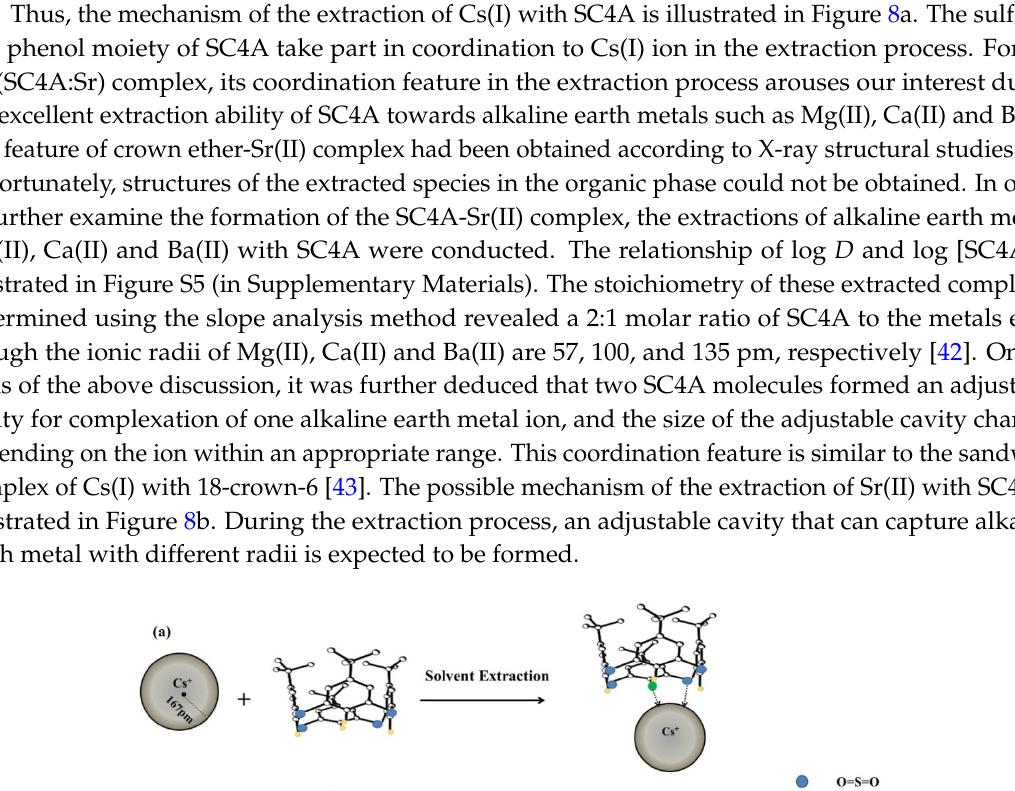
Figure 7. IR spectra (KBr) of SC4A and extracted species: ( a ) SC4A; ( b ) SC4A ‐ Cs(I) complex; and ( c ) SC4A ‐ Sr(II) complex. Conditions: T = 298 K, [SC4A] (o) = 1 × 10 − 3 M, [Metal] (a) = 1 × 10 − 4 M, contact time = 60 min, pH = 6, shaking speed: 150 rpm. SC4A ‐ Cs(I) complex and SC4A ‐ Sr(II) complex were dried in air.